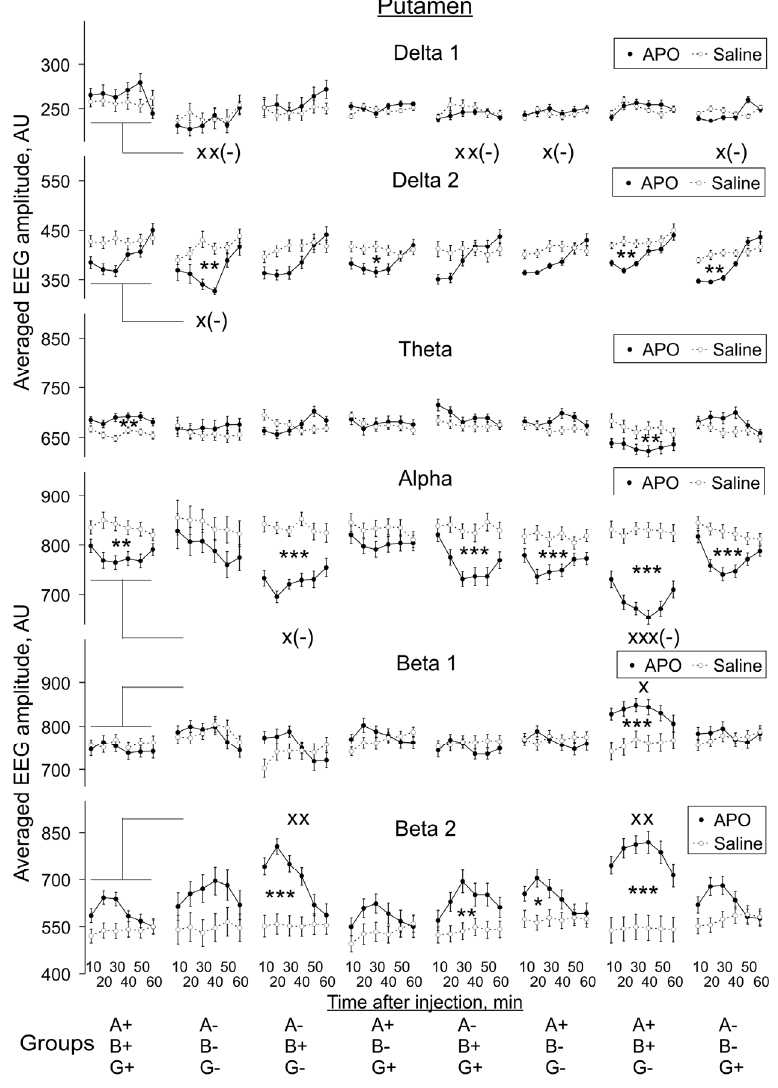
Figure 6. Evolution of apomorphine (APO, 1.0 mg/kg, s.c.) vs. saline effects in “classical” frequency bands of 12 s fragments of EEG from the putamen averaged for consecutive 10 min intervals (abscissa) in knockout mice of different types denoted on the horizontal axes. Ordinate is the averaged absolute values of EEG amplitudes in each of the “classical” bands, in arbitrary units (vertical lines are ± 1 SEM), obtained in experiments with saline and APO (grey and black lines, respectively) in each group. Differences between baseline EEGs in knockout and wild-type mice were used to normalise the APO effects in knockout groups to those in control. Symbols * and x denote the significant differences in APO vs. saline and knockout mice vs. wild-type control, respectively (one, two and three symbols denote p < 0.05, <0.01 and 0.001, respectively). Symbol x(-) denotes the significant enhancement of the APO suppressive effect, for clarity.